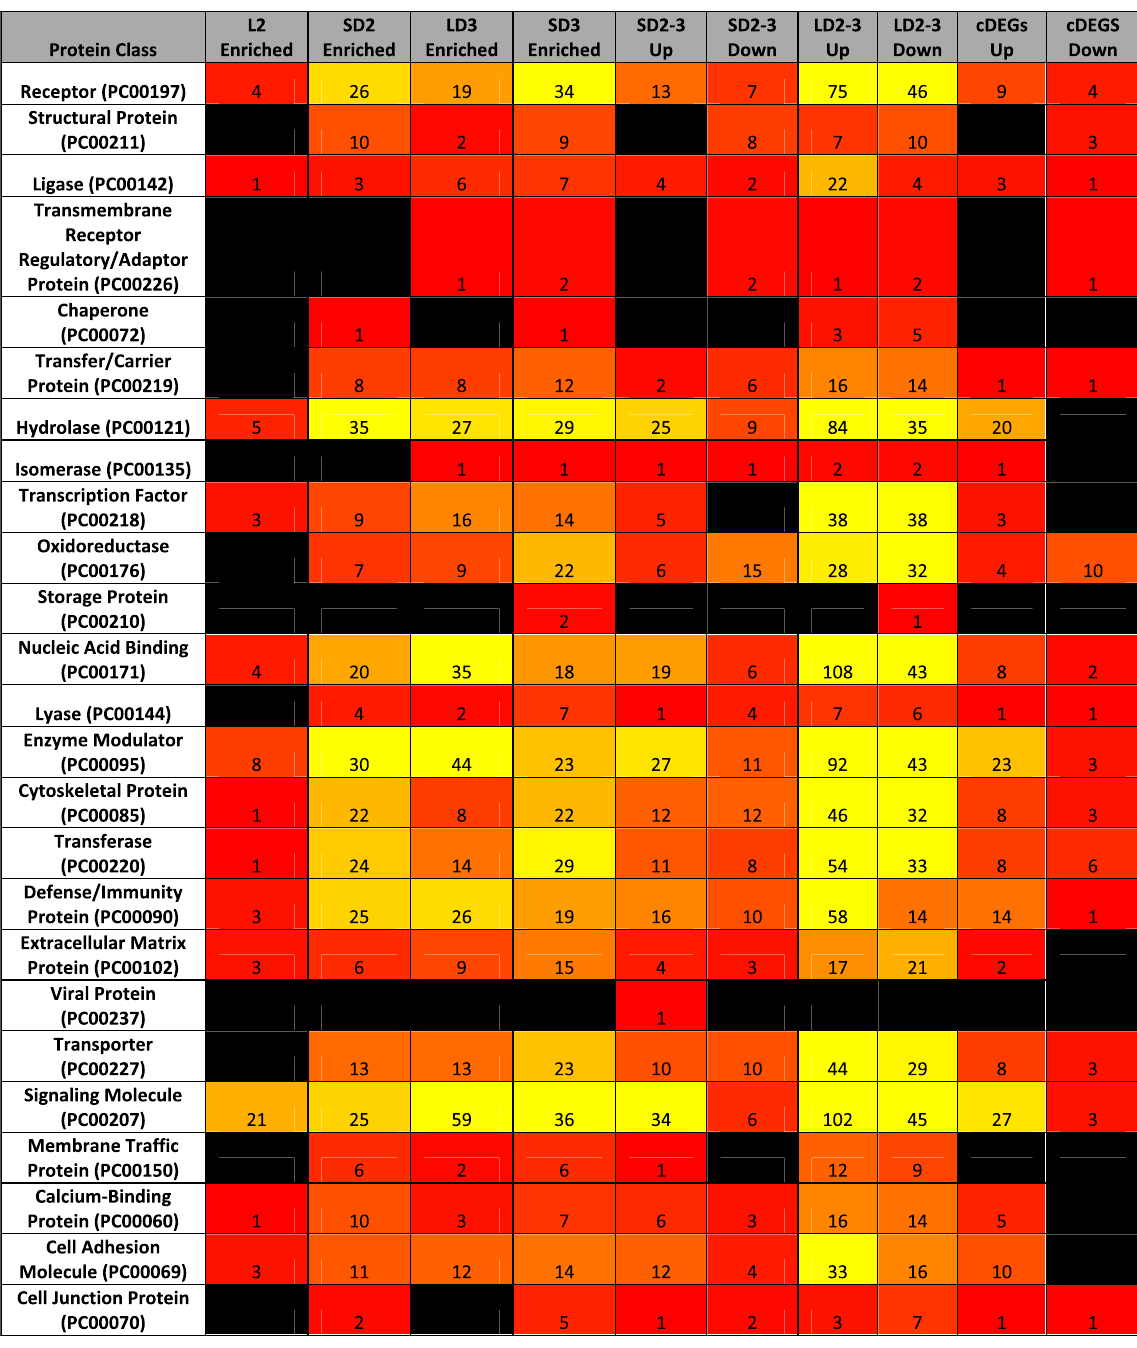
Table 2. Categorization of differentially expressed genes based on PangtherDB protein class. Categorical binning of PantherDB 35 protein classes based upon differentially expressed genes in the steroid and chemotherapeutic models of invasive pulmonary aspergillosis from day to day 3. LD, chemotherapeutic model; SD, steroid model; 2–3, from day 2 to 3; Up, differentially expressed genes increasing in expression; Down, differentially expressed genes decreasing in expression; Enriched, differentially expressed genes of higher transcript expression for the identified model in comparison to the alternate model for a given day; cDEGs Up, differentially expressed genes increasing in expression from day 2 to day 3 in both models; cDEGS Down, differentially expressed genes decreasing in expression from day 2 to day 3 in both models. Color code gradient from null (black) to 1 (red) to 30